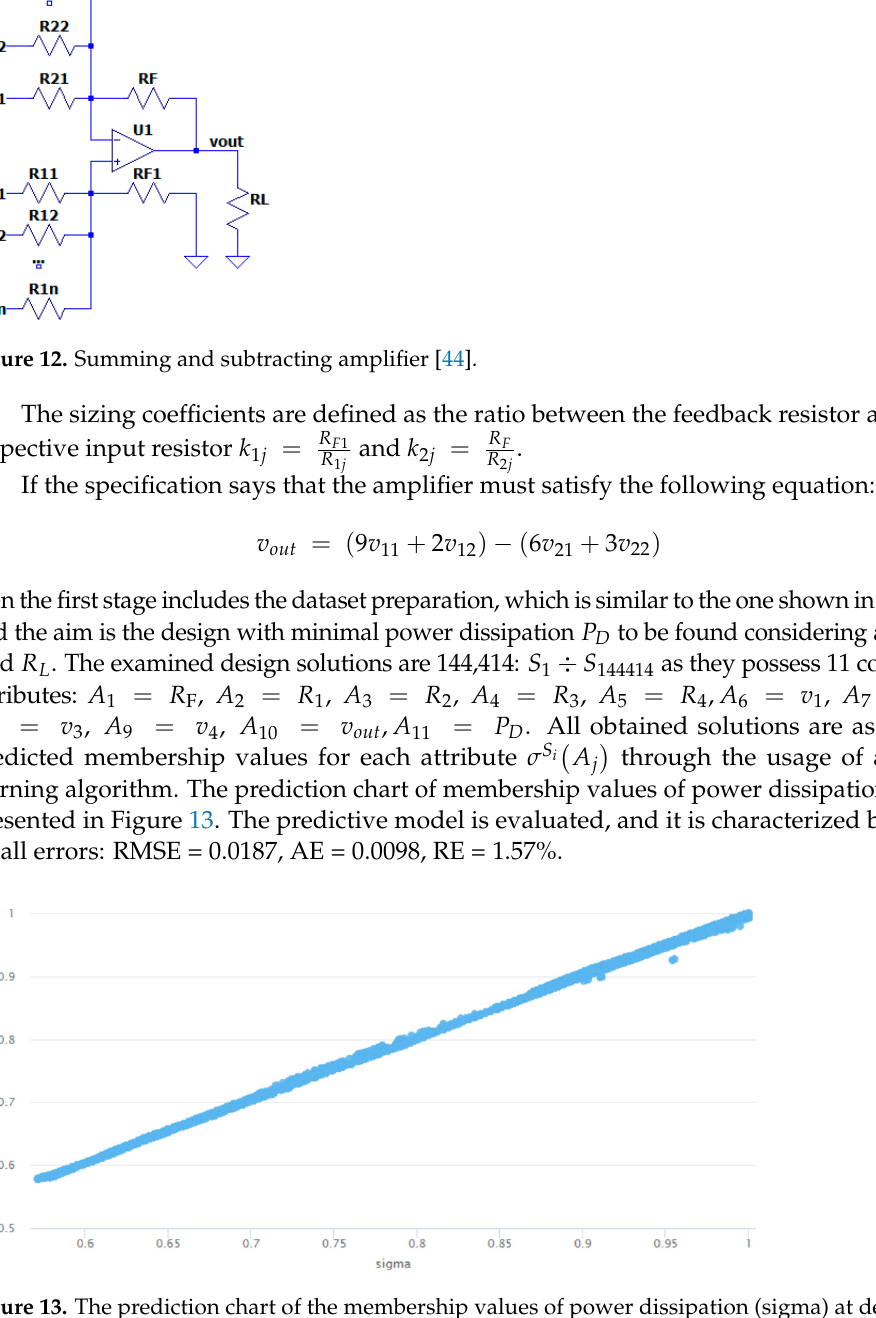
Figure 14. Sigma membership values of ten random designs of summing and subtracting ampli- fier. Stage two includes selecting the most suitable solutions from 144,414 designs. The membership values of the most appropriate 39 designs 𝑆𝑆 (cid:2869) ÷ 𝑆𝑆 (cid:2871)(cid:2877) are calculated, as well as the membership functions of the edges ( 𝑆𝑆 (cid:3036) ,𝑆𝑆 (cid:3038) ) taking into account the attributes 𝐴 (cid:2869) ÷ 𝐴 (cid:2869)(cid:2869) . Then, the m-polar fuzzy graph is constructed. In the third stage, for every attribute, the membership values of the edges between the vertices are calculated and the weights of the solutions are presented in Figure 15. The best solution found is 𝑆𝑆 (cid:2869) according to the predefined user specification.